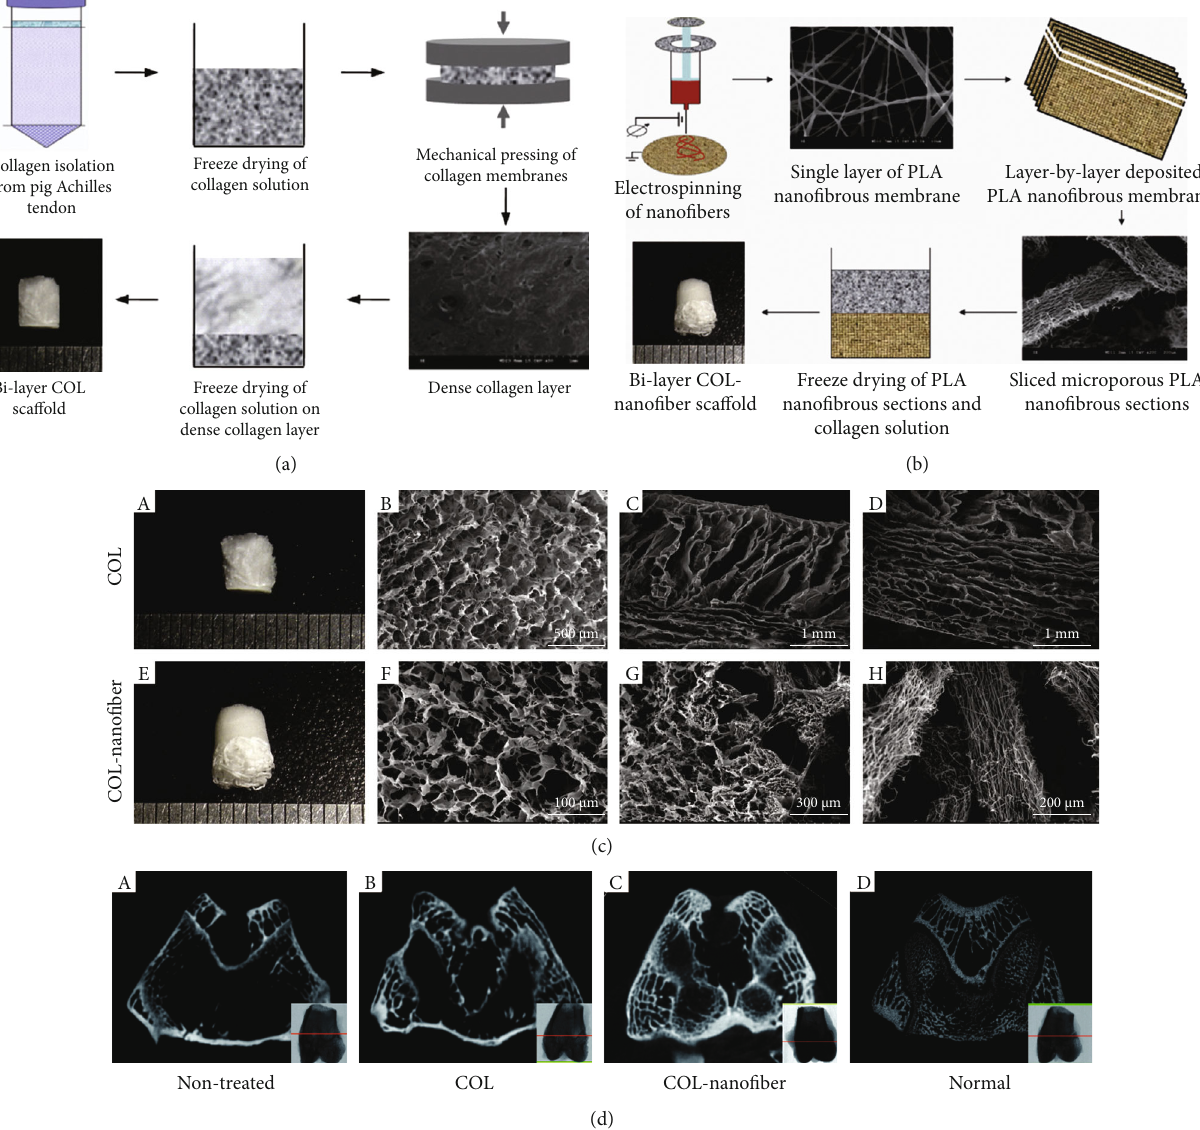
Figure 5: Electrospun PLA nano fi ber/freeze-dried collagen bilayer composite sca ff old for osteochondral tissue engineering. (a) The fabrication process of freeze-dried collagen bilayer sca ff olds and (b) nano fi ber/freeze-dried collagen bilayer composite sca ff olds, and (c) their microstructures. (d) Architecture evaluation of the repaired tissues after 12 weeks of implantation by μ -CT images ((A) nontreated group, (B) freeze-dried collagen bilayer sca ff old group, (C) nano fi ber/freeze-dried collagen bilayer composite sca ff old group, and (D) normal joints). There were abundant subchondral bones formed in the nano fi ber-collagen porous sca ff old group. Adapted with permission from [84]. Copyright © 2013, Acta Materialia Inc. Published by Elsevier